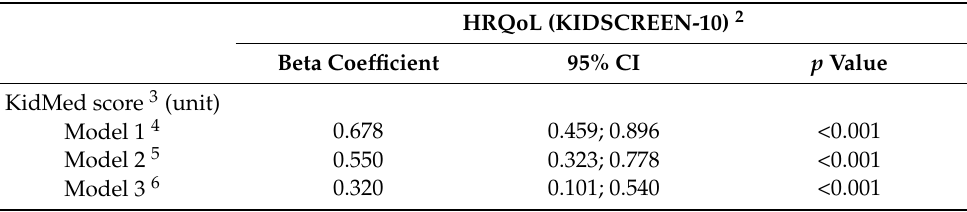
Table 3. Prospective analysis the association between baseline adherence to the Mediterranean diet and health-related quality of life at follow-up in Spanish boys and girls ( n = 1371) 1 . 1 Linear regression analysis. 2 KIDSCREEN-10 ranged from 25.4 to 83.8 with higher score indicating higher HRQoL. 3 KidMed score ranges from − 4 to +8 with higher score indicating a higher adherence